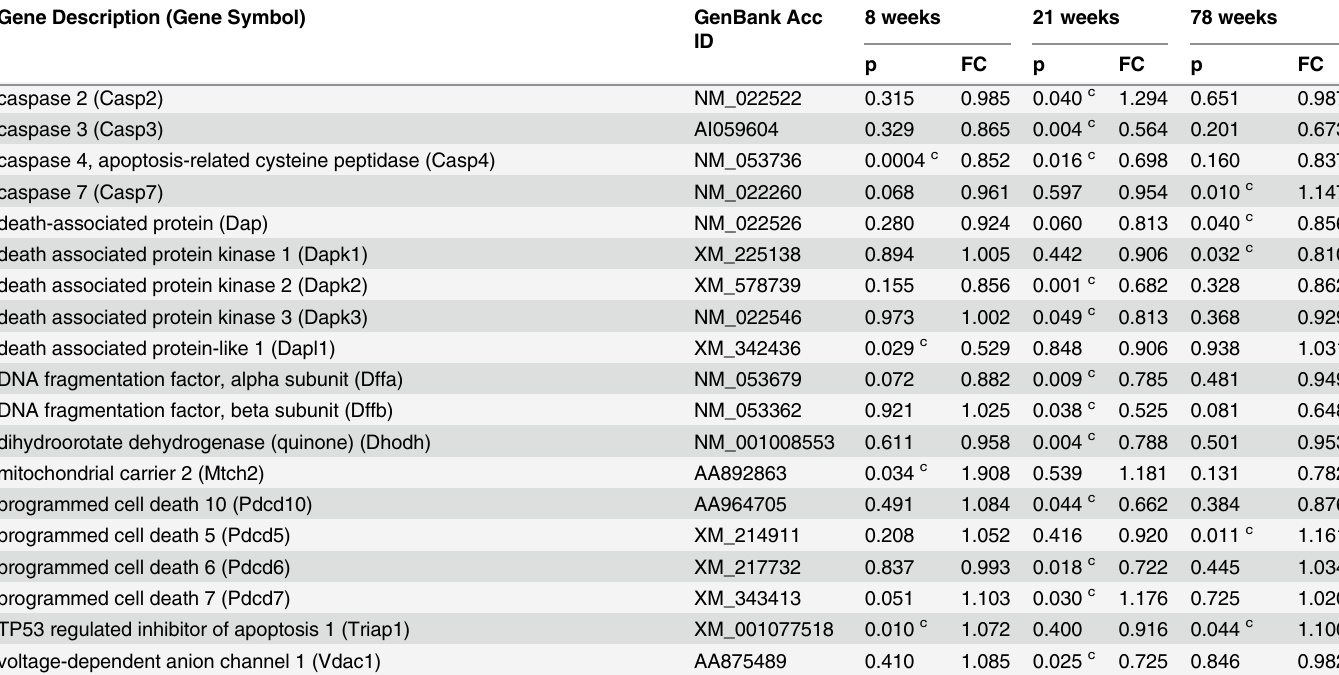
This table represents a list of sexually dimorphic genes in one or more of the 3 ages (young, adult and old). a Gene Ontology (GO) term (number of genes evaluated).